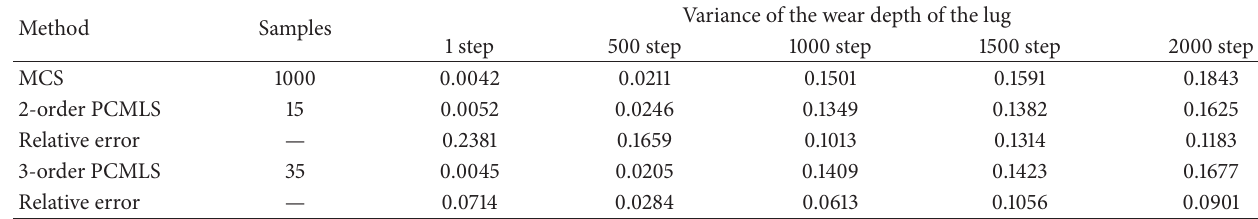
Table 4: Comparative results of the variance of the wear depth of the lug along the time axis.